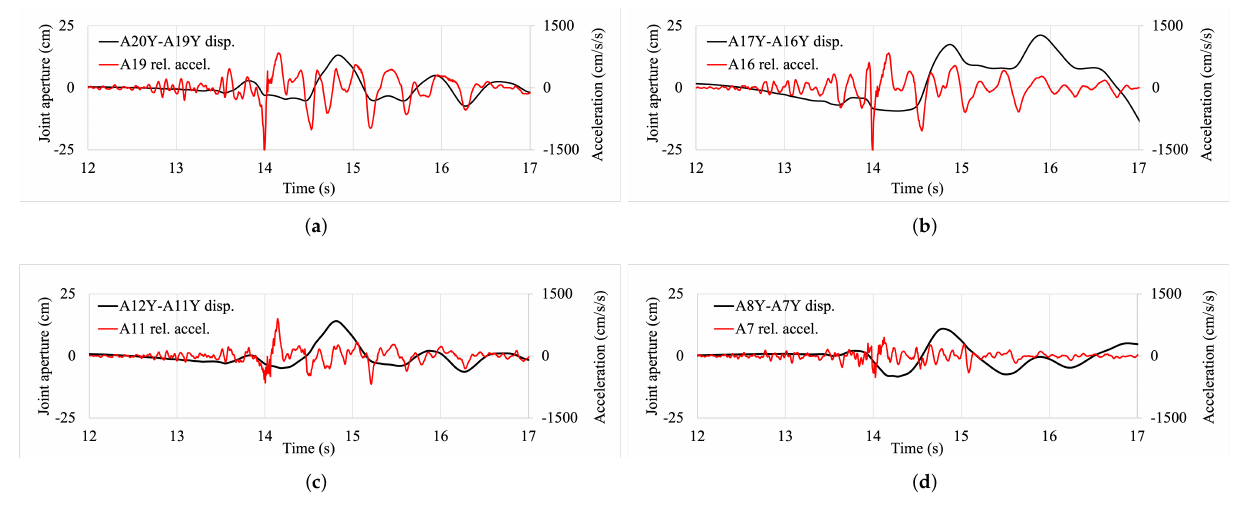
Figure 10. Time histories of the structural joint openings (in cm) between masonry and RC buildings (black curves) and of the relative (with respect to the ground) accelerations (red curves, in cm/s 2 ): ( a ) level 3, joint near sensor A19; ( b ) level 3, joint near sensor A16; ( c ) level 2, joint near sensor A11; ( d ) level 2, joint near sensor A7. Sensor locations are reported in Figure